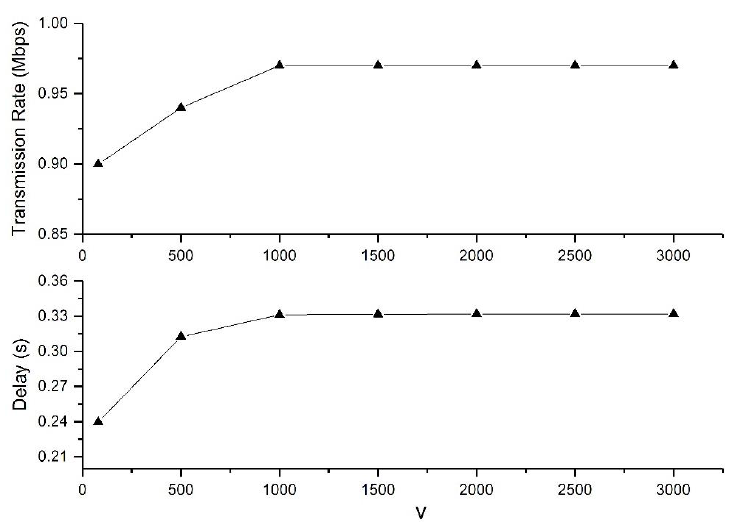
Figure 4. Network performance of the distributed rate-control and delay-aware (DRDA) algorithm versus the value of V .